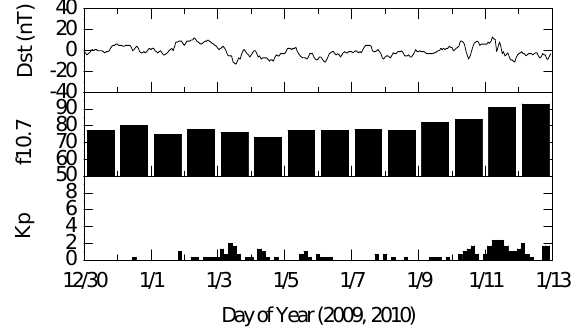
Fig. 3. VTEC time series above the Haiti epicenter from 30 Decem- ber 2009 to 12 January 2010. The red, blue, and two black curves denote the observed TEC, associated median, and upper/lower bound (UB/LB), respectively. The red and black shade areas denote difference of O-UB and LB-O, respectively, where O is observed